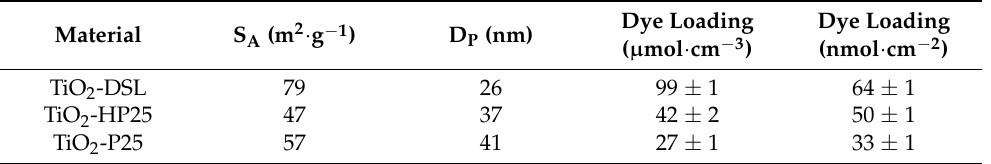
Table 1. The specific surface area (S A ), the average pore diameter (D P ), and the amount of desorbed dye per unit area/volume of